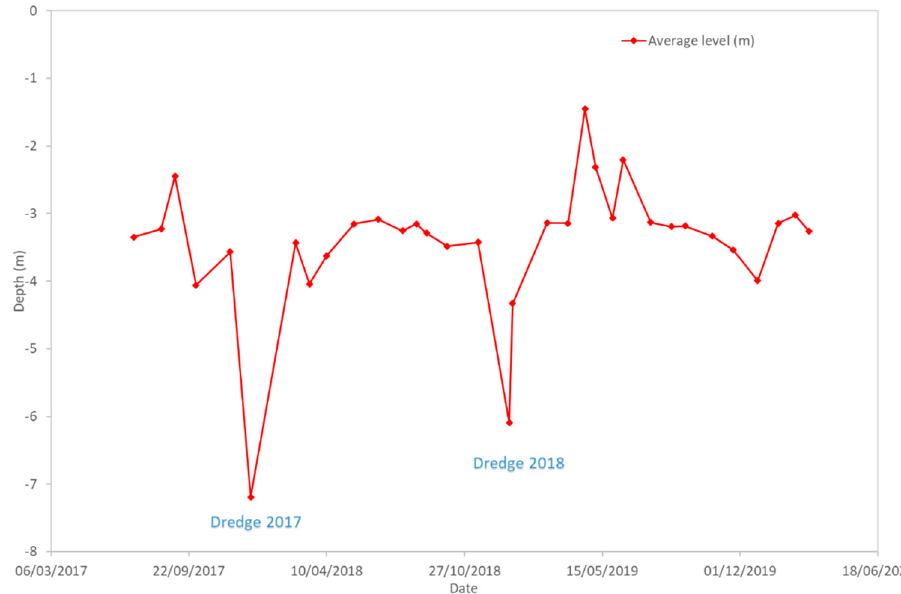
Figure 8. Average depth of the bottom of the dock in the Port of Luarca.